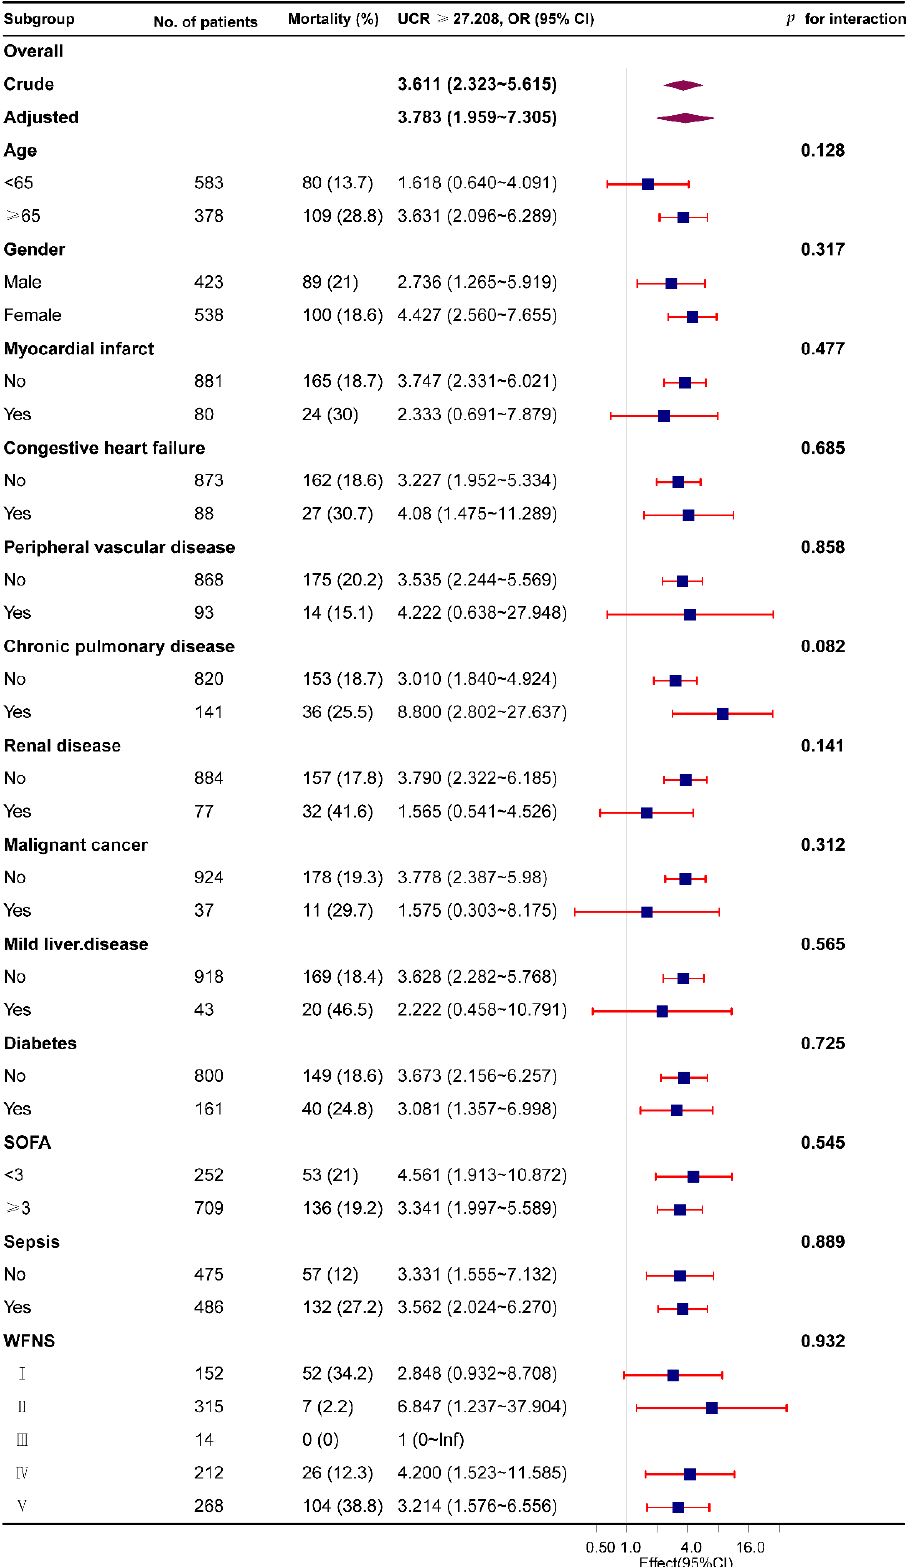
Figure 4. The relationship between the UCR and in-hospital mortality in subgroup analysis. CI, confidence interval; UCR, urea nitrogen to creatinine ratio; WFNS, World Federation of Neurosur- gical Societies